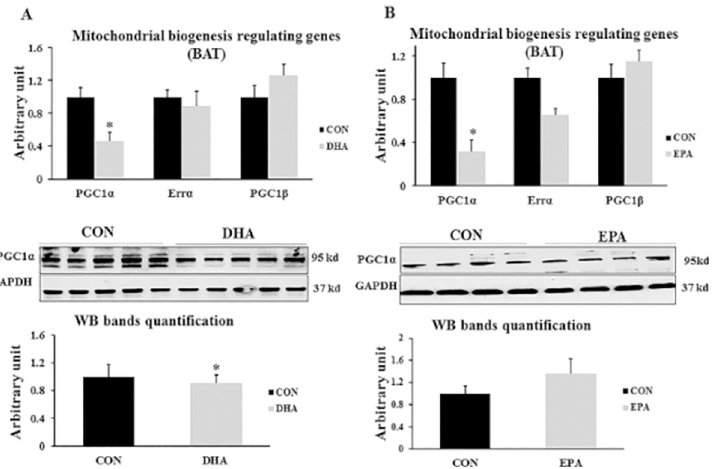
Fig 7. The effect of DHA and EPA on mitochondrial biogenesis regulating genes. C2C12 cells were treated with white adipogenesis induction differentiation medium (BIDM) in the absence (CON) or presence of individual doses of 50 μ M EPA and 50 μ M DHA for 7 days. All the values of RT-qPCR are normalized to the expression levels of 18s genes and calculated in arbitrary units, n = 6. Data are represented as mean ± SEM. The significant difference is presented as � P < 0.05, Student’s t test. The level of GAPDH is used as a housekeeping gene to normalize the Western blots data (A) Effect of DHA on the expression of mitochondrial biogenesis regulating genes. (B) Effect of EPA on the expression of mitochondrial biogenesis regulating genes.